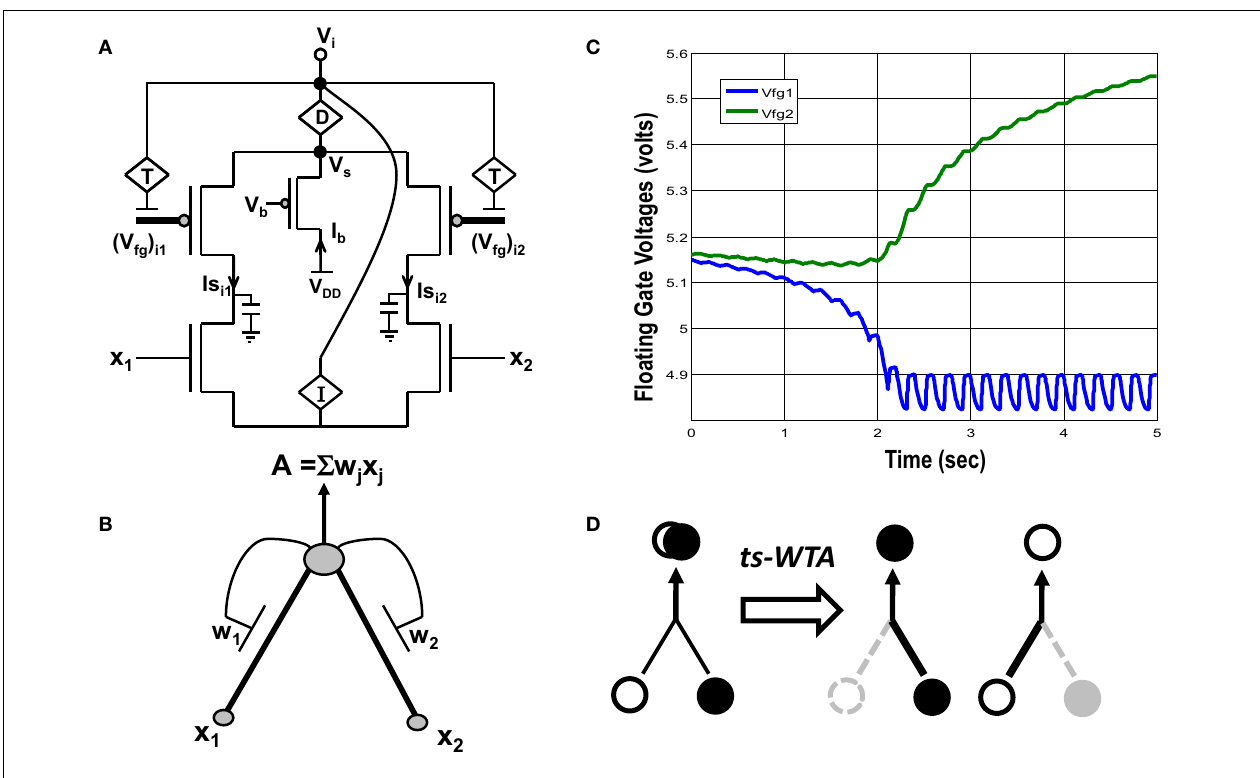
FIGURE 1 | (A) Actual circuit of the ts-WTA learning cell and (B) its abstract model. In (A) (V fg ) i1 , (V fg ) i2 , and in (B) W1, W2 show the floating gate based weighted connections. x 1 , x 2 are inputs and node voltage V i is activation of the cell which is equivalent to A in (B) . (C) Shows ts-WTA evolution of